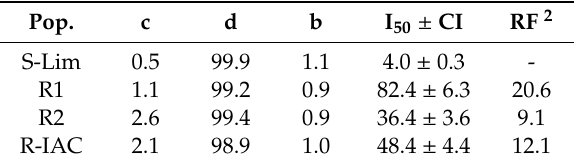
Table 2. Parameters of the sigmoidal equations 1 used to estimate the glyphosate concentration ( µ M) required to inhibit the EPSPS by 50% (I 50 ) in glyphosate-resistant and -susceptible slender amaranth ( Amaranthus viridis L.) populations (Pop.) collected in citrus orchards from S ã o Paulo State, Brazil.